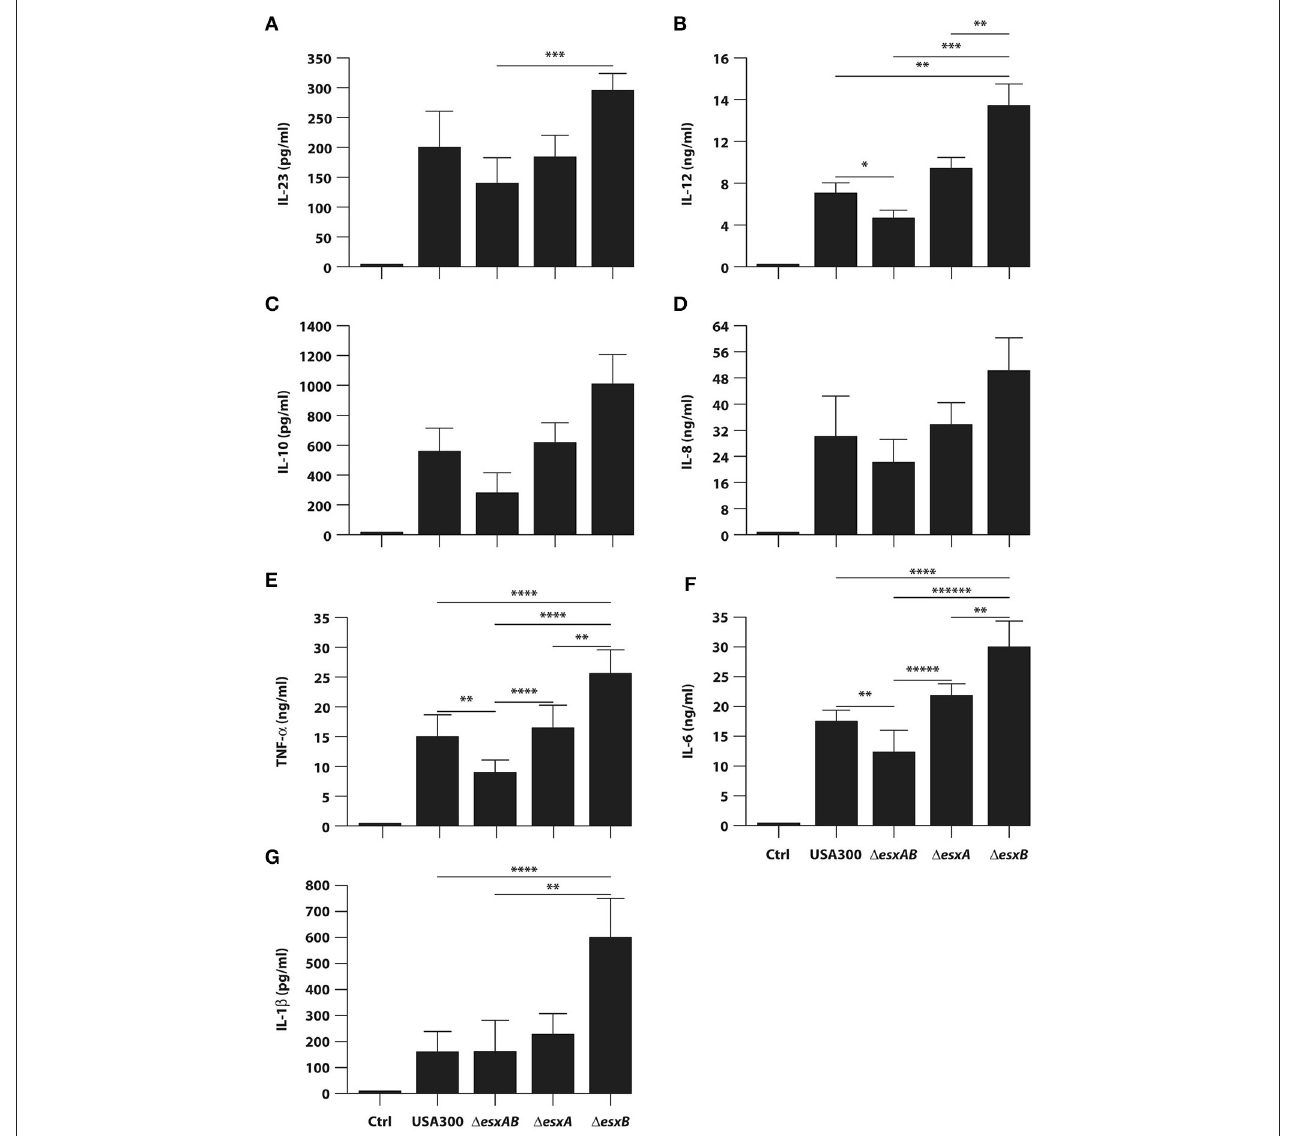
FIGURE 4 | Cytokine production by DC infected with wild type USA300 or esx mutants. DC were left untreated (Ctrl) or infected for 24 h with wild type USA300 or 1 esxAB , 1 esxA, and ∆ esxB mutants. (A–G) IL-23 production was measured in DC culture supernatants by ELISA while, the secretion of IL-12, IL-10, IL-8, TNF- α , IL-6, and IL-1 β was instead evaluated by Inflammatory Cytokine array kit. The results represent means ± SEM of 6 independent experiments. Statistical Significance was calculated by Student’s t- test for paired data. * P = 0.003; ** P < 0.05; *** P < 0.01; **** P < 0.02; ***** P = 0.03; ****** P = 0.006. Statistics refers to strains at the extremity of the horizontal